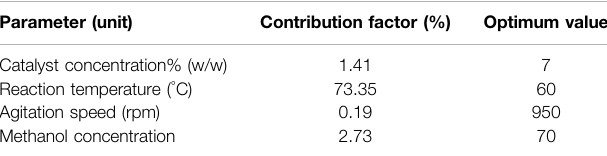
TABLE 7 | Fit and model comparison characteristics of castor oil esteri fi cation Std. Dev.